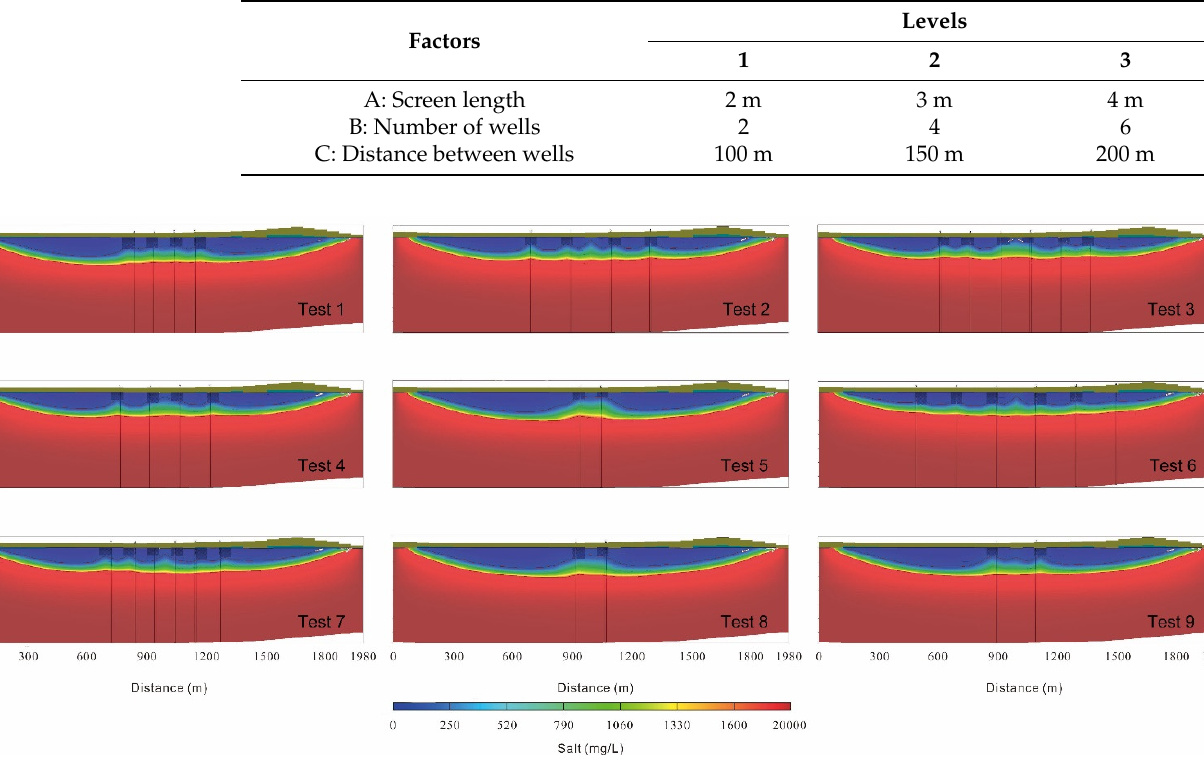
Figure 4. Schematic diagram of the linear well layout scheme. Table 5. Factor-level table of well layout plan (3 factors and 3 levels).